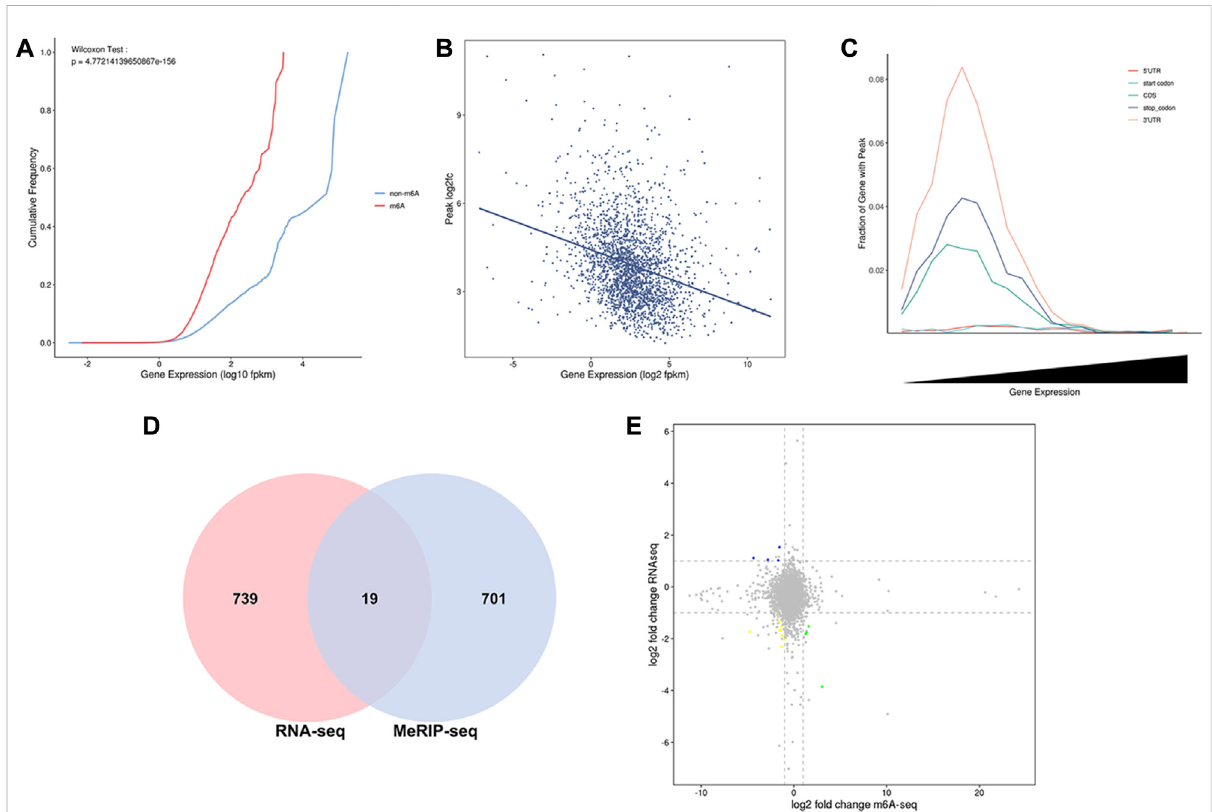
FIGURE 5 Combined MeRIP-seq and RNA-seq analysis. (A) Cumulative curvefor gene expression with/without m 6 A modi fi cation. The red line represents the gene set with m 6 A peak signal, and the blue line represents the gene set without m 6 A peak signal. (B) Relation of gene expression and peak enrichment fold change (C) Peak distribution in different gene elements and expression abundance. (D) Venn diagram of differential gene distributioninmethylomicsandtranscriptomics (E) Nine-quadrantplotofDEGswithdifferentialpeaks.Thehorizontalaxisisthefolddifference (log 2 ) in m 6 A peak abundance, and the vertical axis is the fold difference (log 2 ) of gene expression abundance in the transcriptome. Blue dots representupregulatedgenesanddownregulatedm 6 Agenes,yellowdotsrepresentdownregulatedgenesanddownregulatedm 6 Agenes,andgreen dots represent downregulated genes and upregulated m 6 A